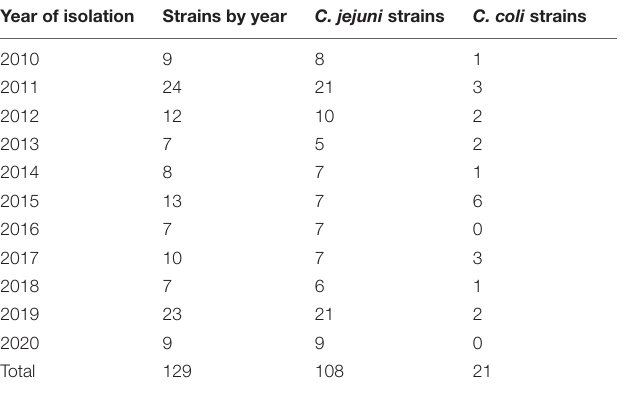
TABLE 1 | Number of strains of C. jejuni and C. coli used in the study by year of isolation. Year of isolation Strains by